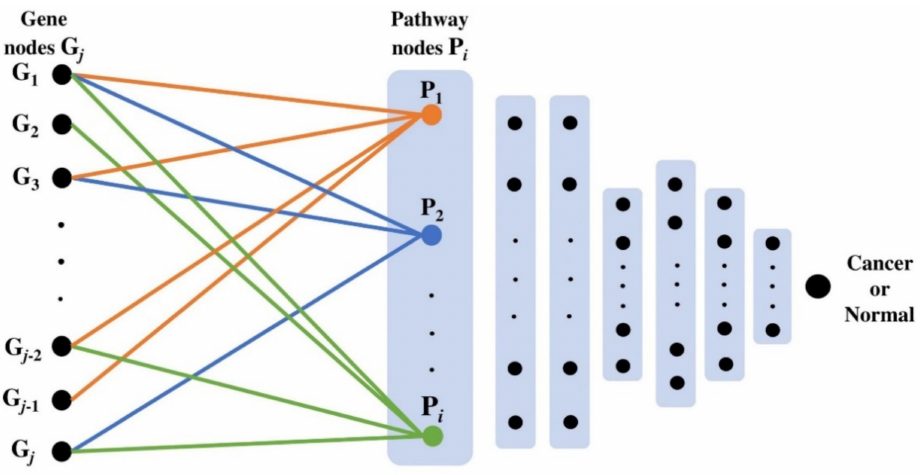
Figure 7. PathDeep model